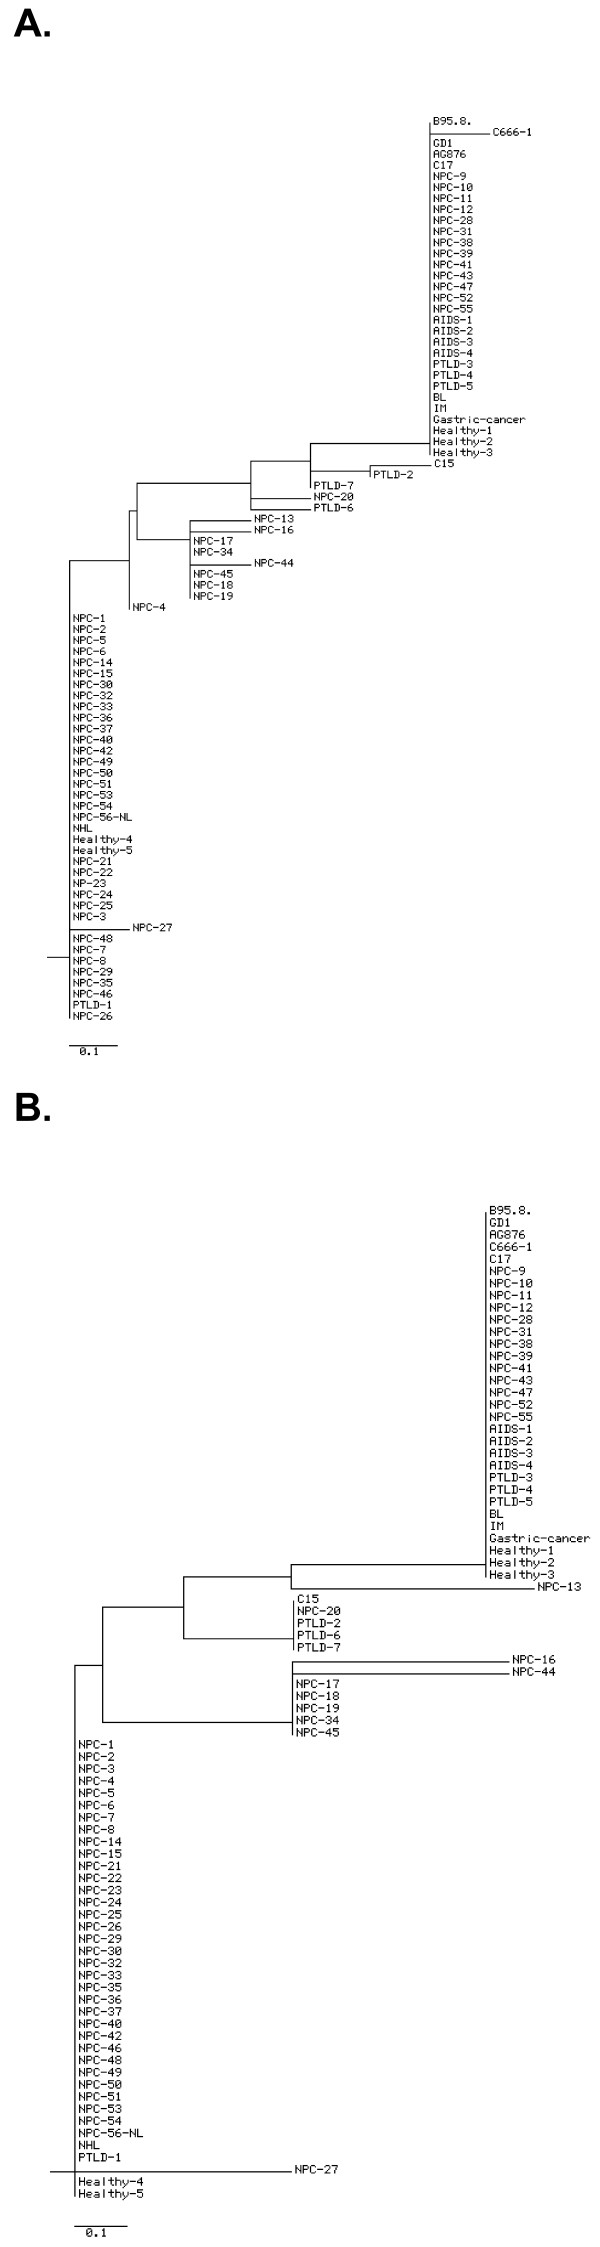
Phylogenetic tree of individual BARF1 gene variants at the nucleotide level (A) and at the amino acid level (B). AIDS: Acquired immune deficiency syndrome; PTLD: post-transplant lymphoproliferative disorder; IM: infectious mononucleosis; BL: Burkitt's lymphoma; NPC-NL: NPC from The Netherlands (Dutch NPC); NHL: non-Hodgkin lymphoma. The scale reflects the evolutionary distance.